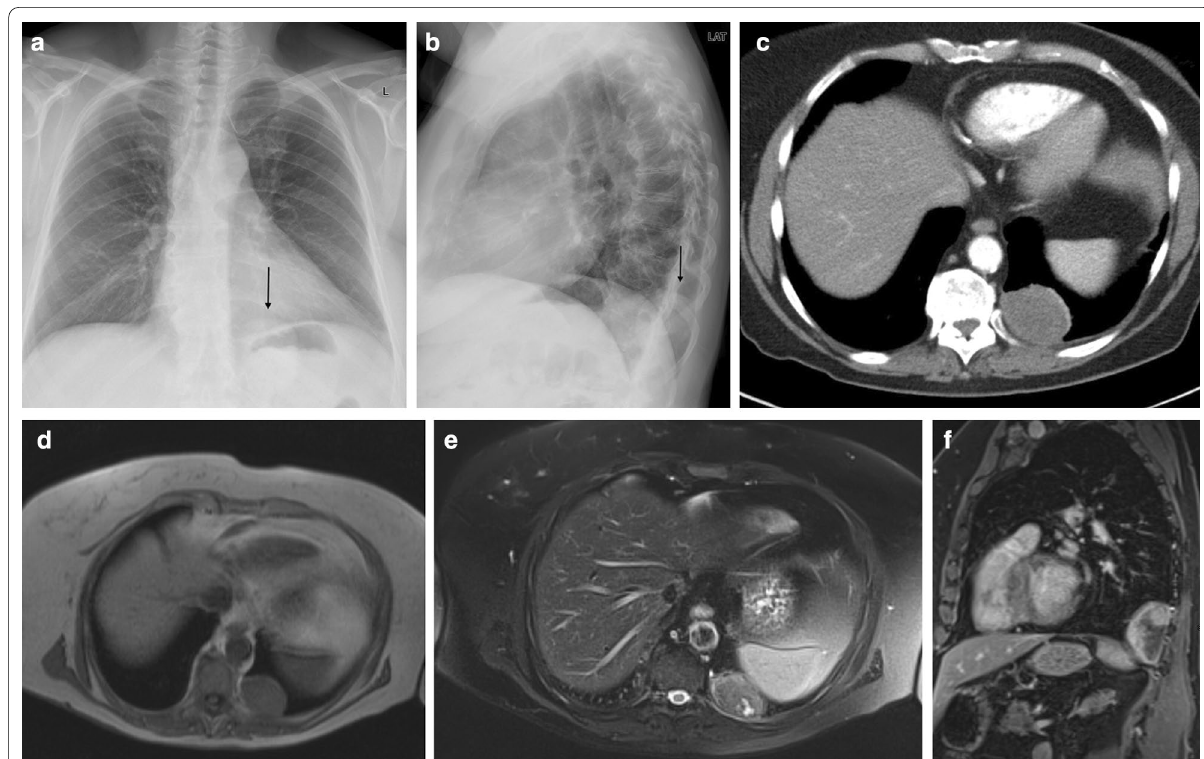
Fig. 4 Diagnosis: solitary fibrous tumor. Technique: standard chest radiography, contrast-enhanced chest CT and MRI. Description: A 68-year-old woman presented with progressive complaints of dyspnea, cough, and limited weight loss. Postero-anterior and lateral radiographs ( a , b ) show a well-delineated mass (arrow) located posteriorly in the left lower lobe. Axial contrast-enhanced CT in the mediastinal window setting ( c ) shows a well-delineated homogeneous pleural-based mass. There is no invasion of the surrounding structures. On the axial T1-WI MR image ( d ), the lesion has a homogeneous isointense signal intensity to muscle. On the axial T2 blade FS MR image ( e ), the lesion has a low signal intensity with peripheral enhancement on the sagittal T2W FS MR image after i.v. contrast administration ( f